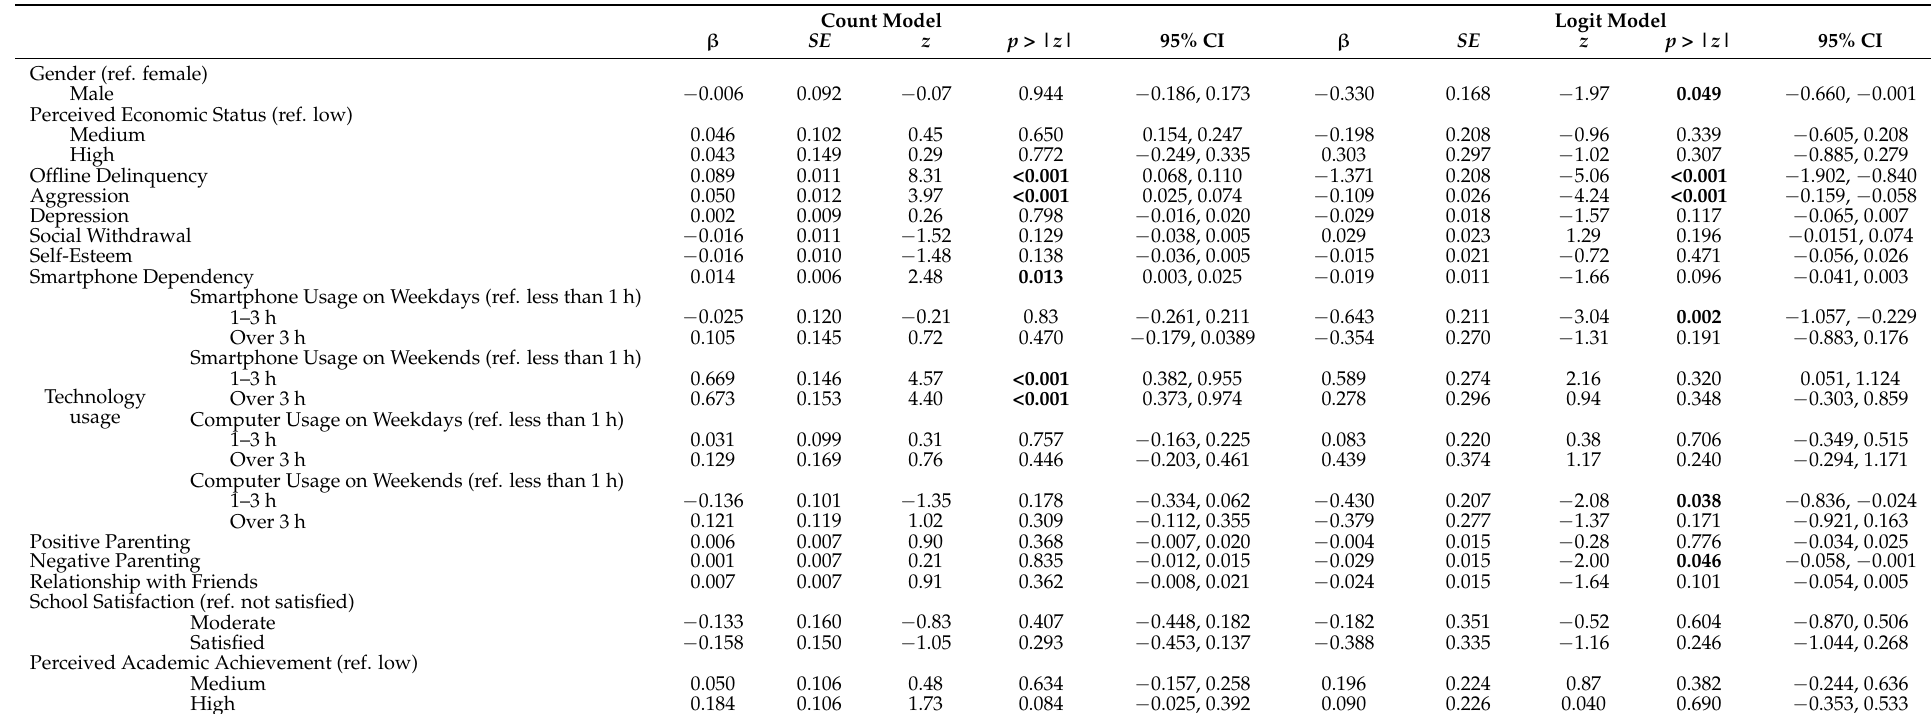
Table 3. Zero-inflated negative binomial regression results for the frequency of cyberbullying perpetration ( N =